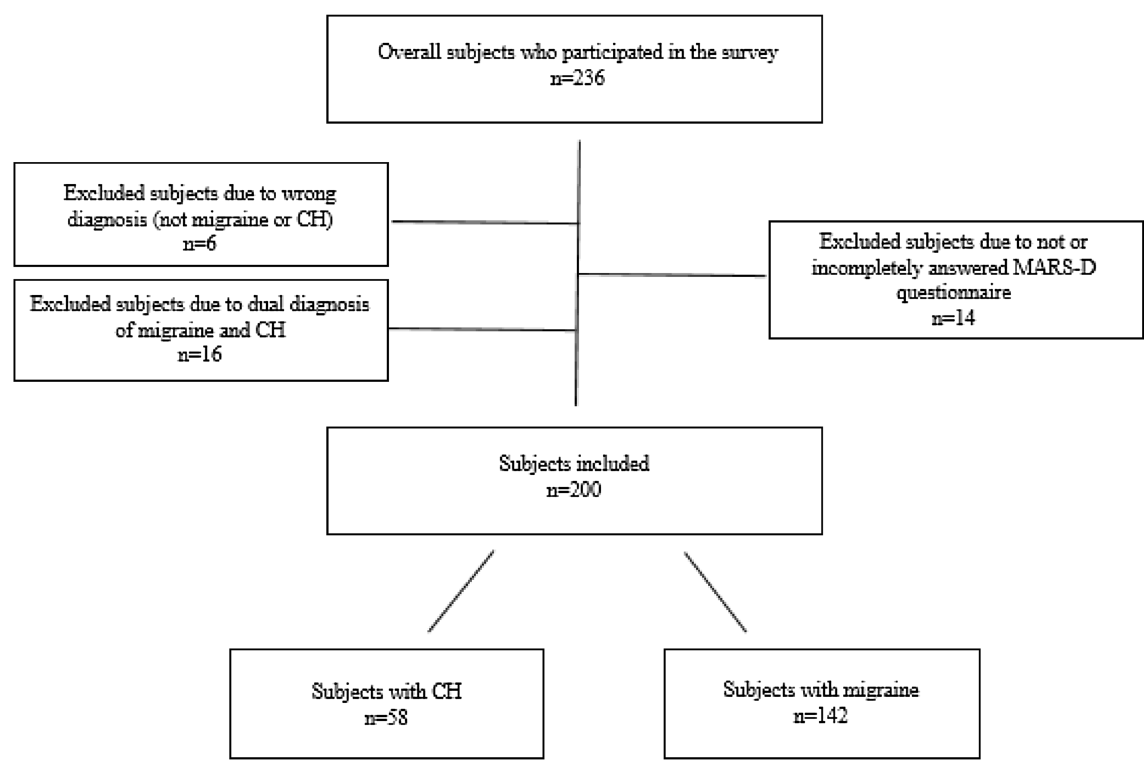
Figure 1. Flowchart for the inclusion of the subjects in the study.